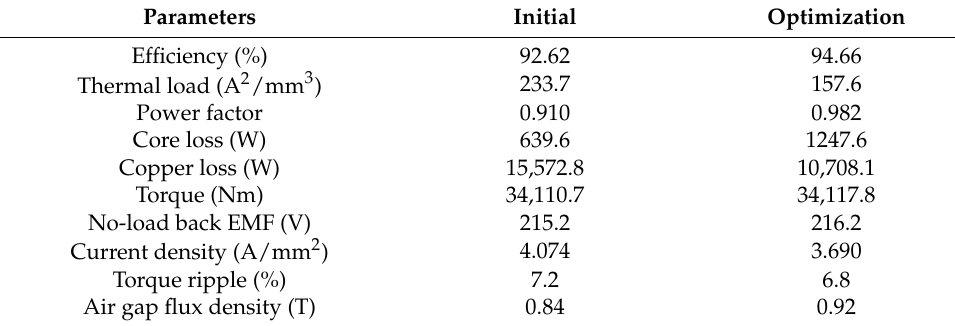
Table 5. Comparison of initial and optimized performance.